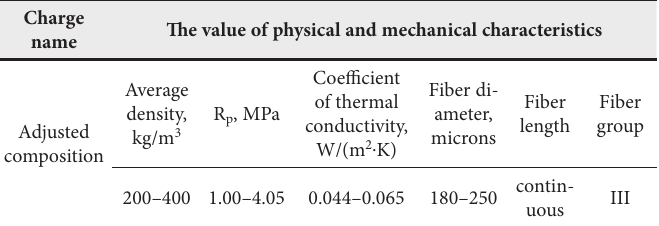
Physico-mechanical characteristics of the modified basalt